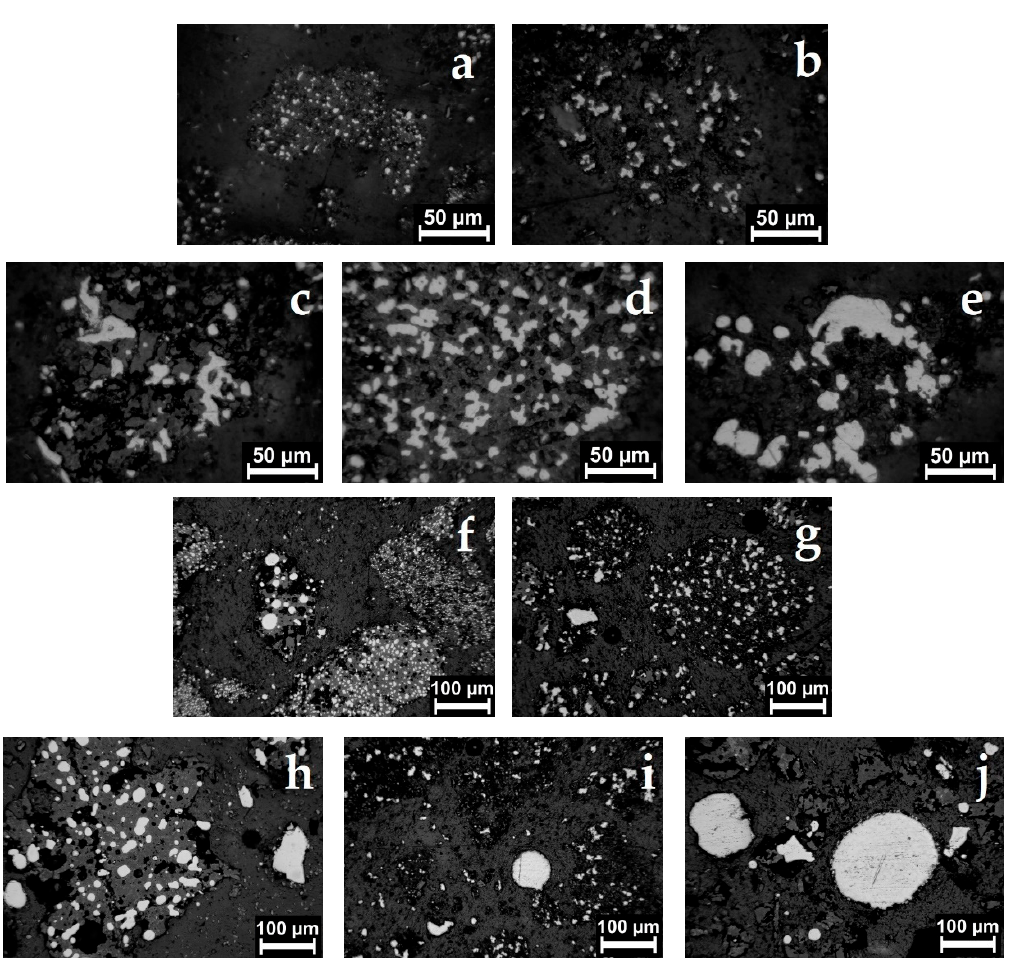
Figure 10. The microstructure of the red mud sample B after the carbothermic roasting during 180 min without addition ( a ), and with addition of 9.1% ( b ), 13.65% ( c ), 18.2% ( d ), 27.3% ( e ) Na 2 SO 4 at 1150 °C; without addition ( f ), and with addition of 9.1% ( g ), 13.65% ( h ), 18.2% ( i ), 27.3% ( j ) Na 2 SO 4 at 1200 °C.